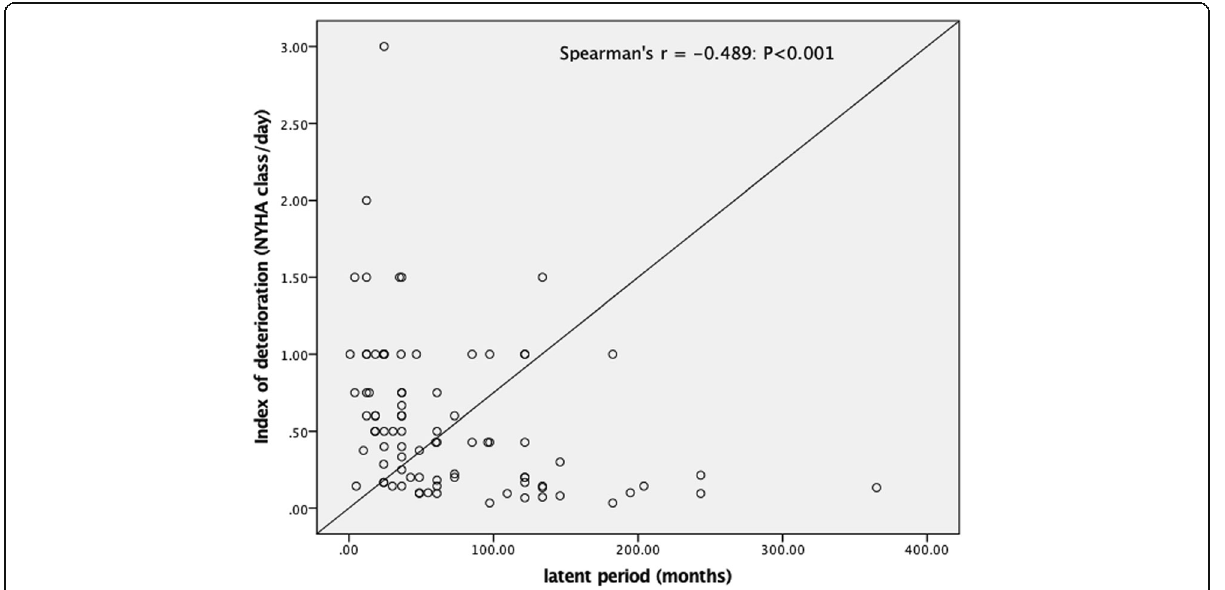
Fig. 1 Correlation between index of deterioration and latent